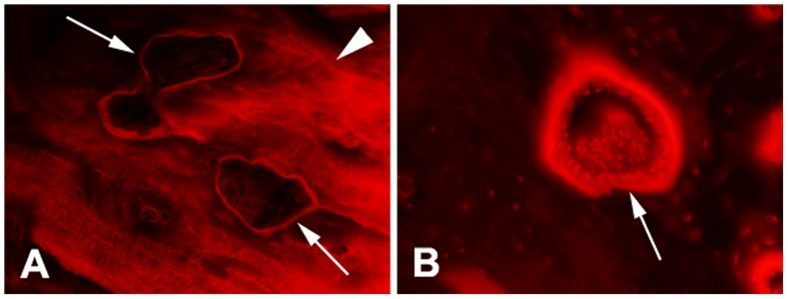
Resorption cavities in peri-screw bone (1 month after surgery).A) cutting cavities (arrow) were covered by a thin layer of basic fuchsin stained tissue and contacted with microdamage; B) closing cavity (arrow) was covered by a thick seem of osteoid, on which there was a single layer of cuboidal osteoblasts attached.